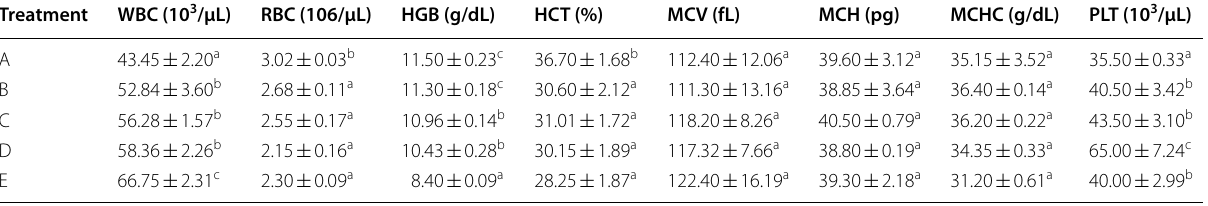
A—control; B—0.32%; C—0.66%; D—1.31%; E—2.63% * Values with different superscripts within the same column are significantly different at p < 0.05